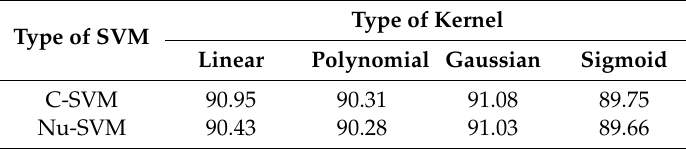
Table 4. The prediction accuracy of the SVM-based swallowing quality-of-life,